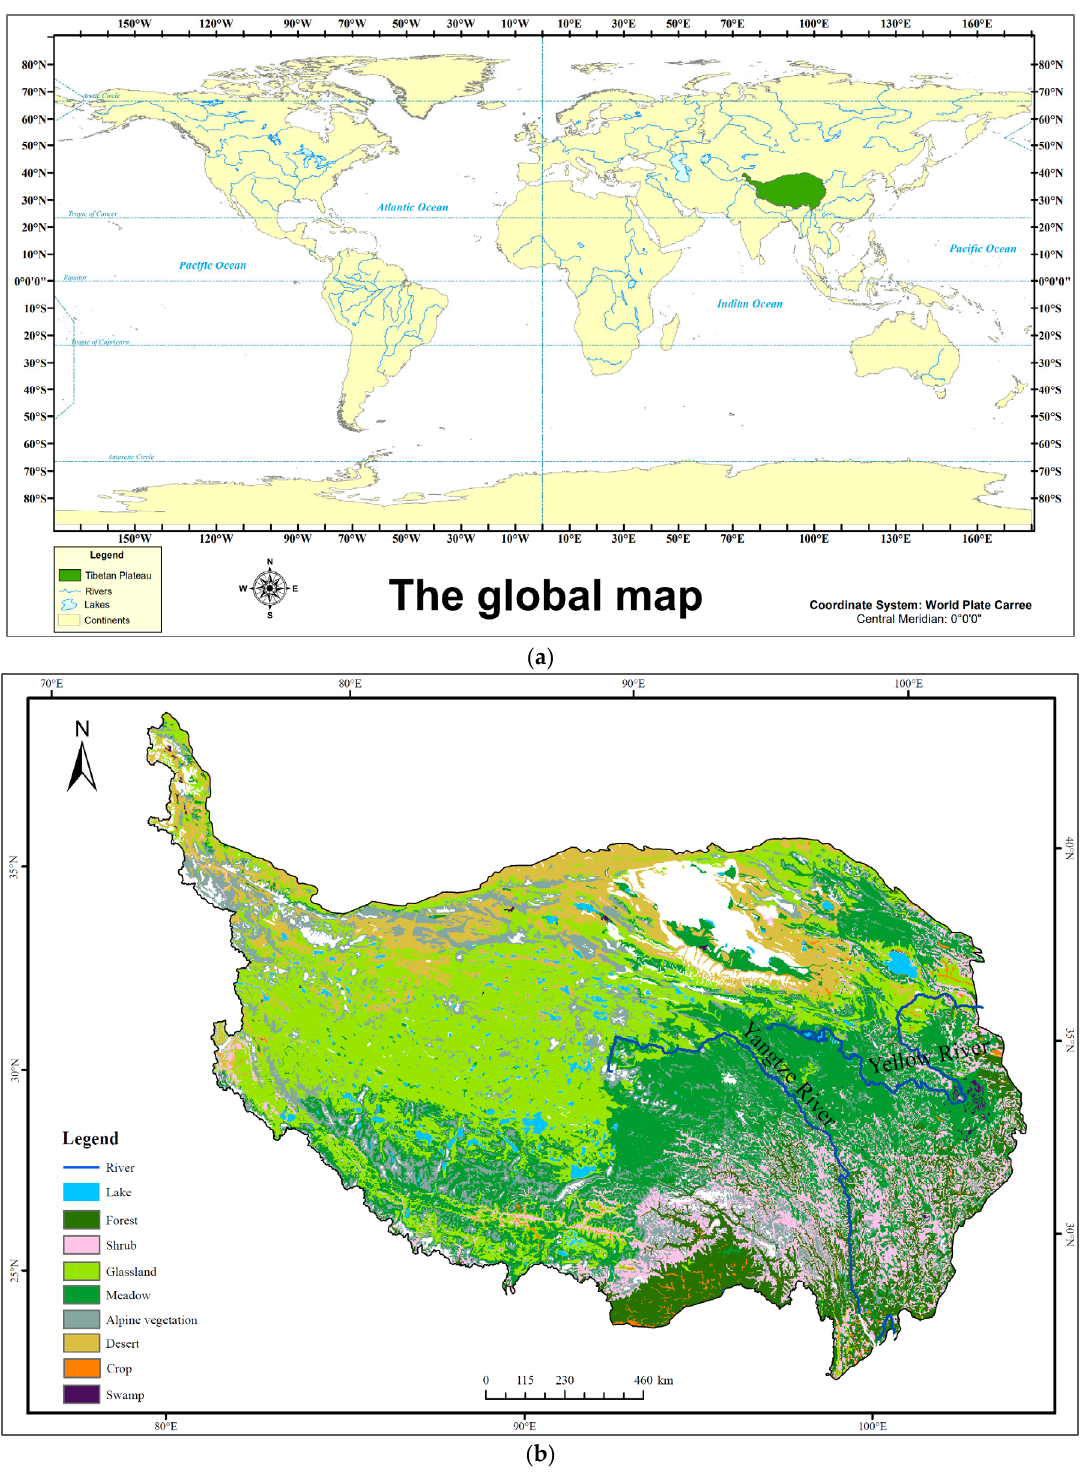
Figure 1. ( a ) The location of the Tibetan Plateau [48] in the world map, and the world map from ArcGIS. ( b ) Distribution of vegetation types on the Tibetan Plateau [49].